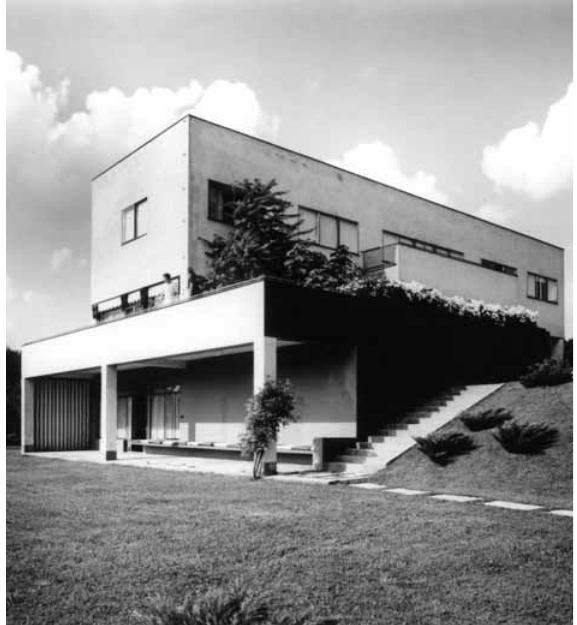
fig. 10. j. Gočár, Villa Sochor at Dvůr Kralové,